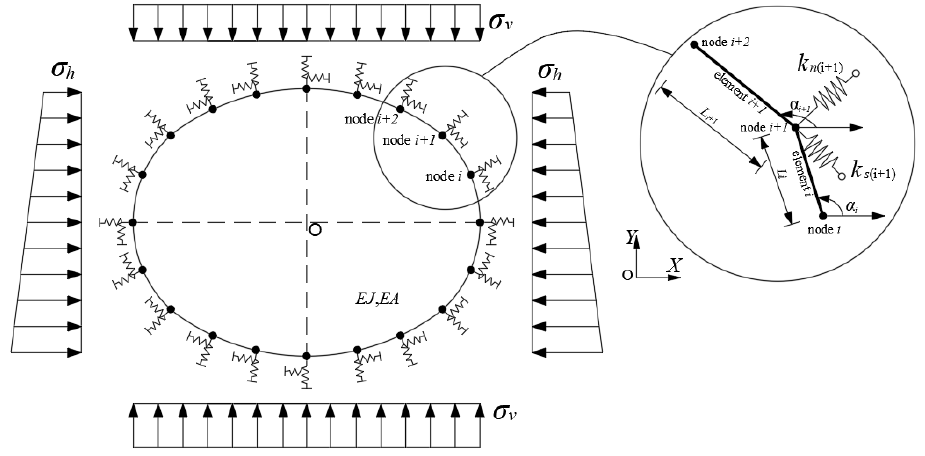
Figure 1. Sketch of quasi-rectangular tunnel lining.